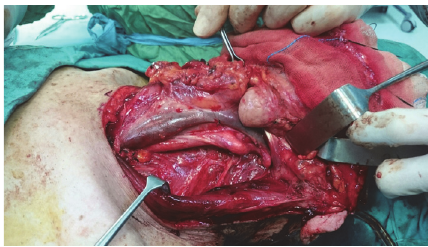
Figure 1: During the neck dissection, tortuous internal carotid artery mimicking a metastatic mass in neck level IIb was